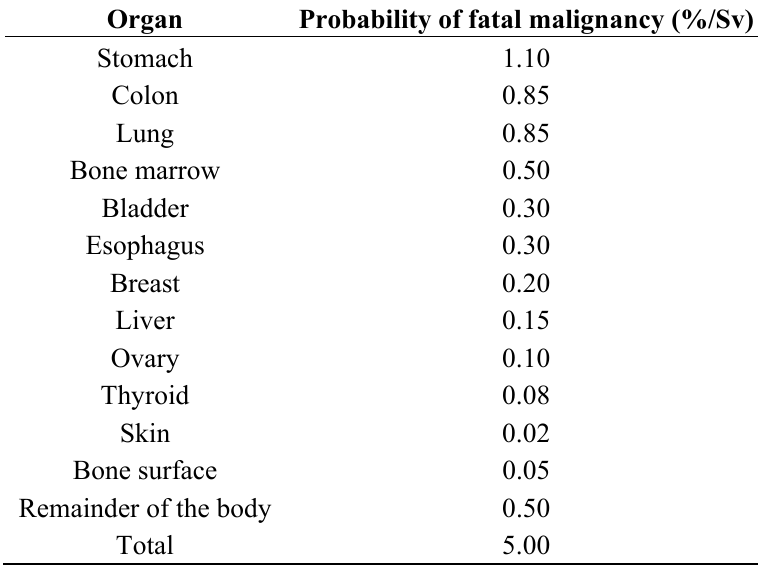
Table 1. Lifetime probability of developing a fatal second cancer by organ site from NCRP report 116 (Reprinted with permission of the National Council on Radiation Protection and